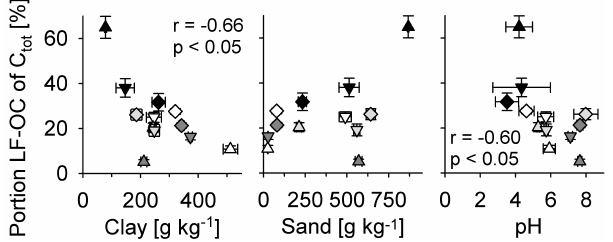
Fig. 7. Relation of the contribution of the LF (light fraction) at 0– 10cm soil depth to total OC to clay content, sand content, and pH at 0–10cm soil depth (black: coniferous forest, dark grey: croplands, light gray: grasslands, white: deciduous forests, C tot : total